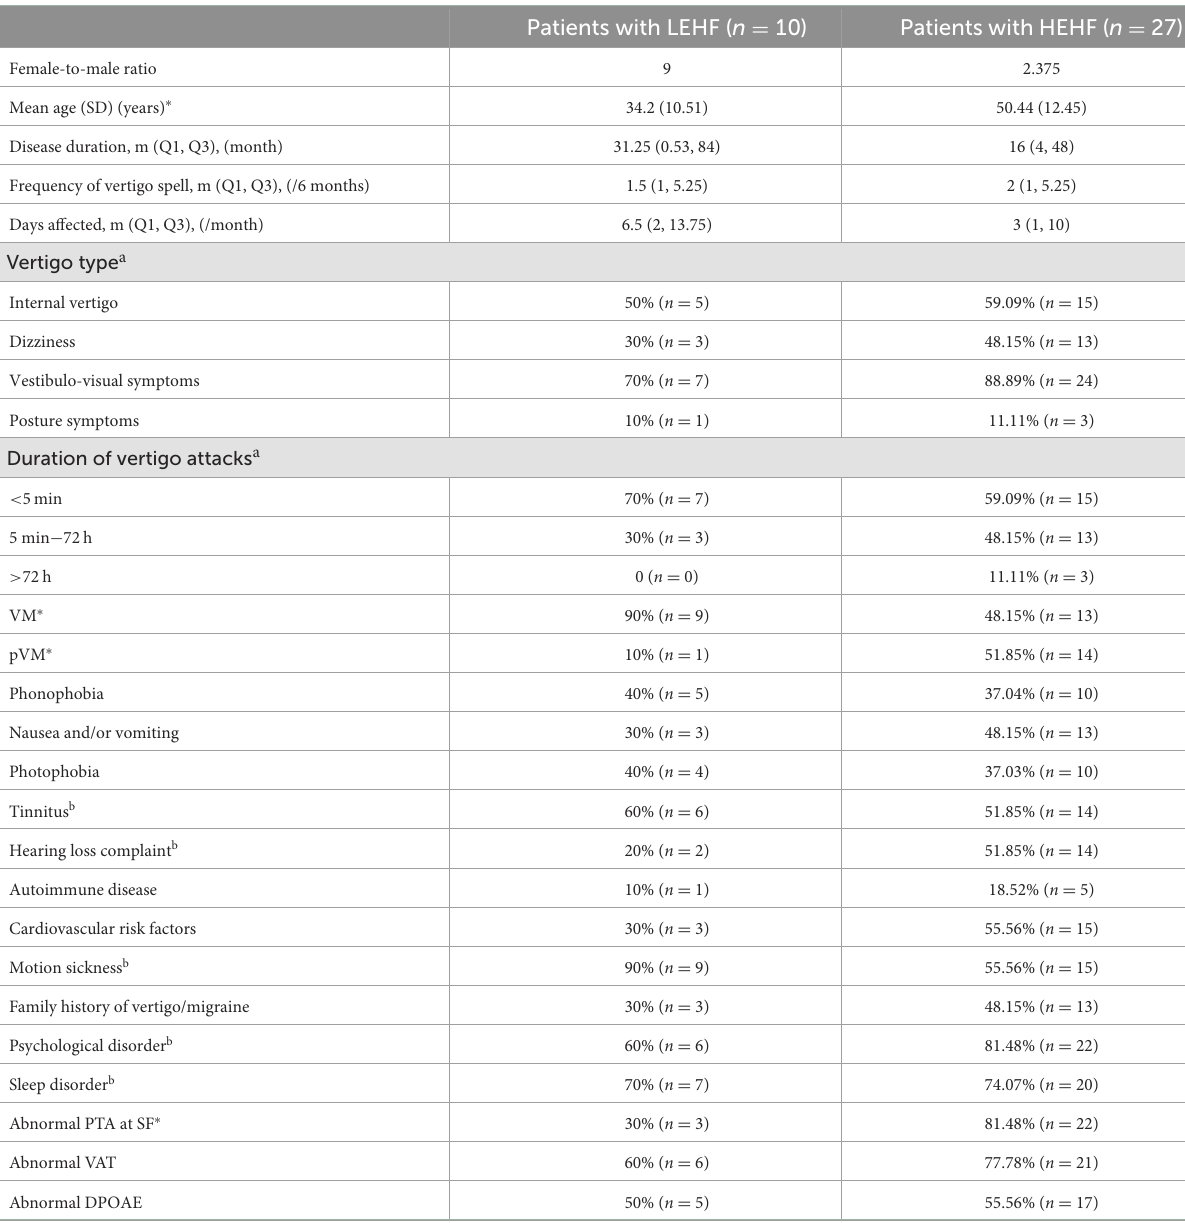
TABLE 5 Clinical characteristics of patients with low mean EHF hearing threshold (LEHF) and those with high mean EHF hearing threshold (HEHF). Patients with LEHF ( n = 10) Patients with HEHF ( n =